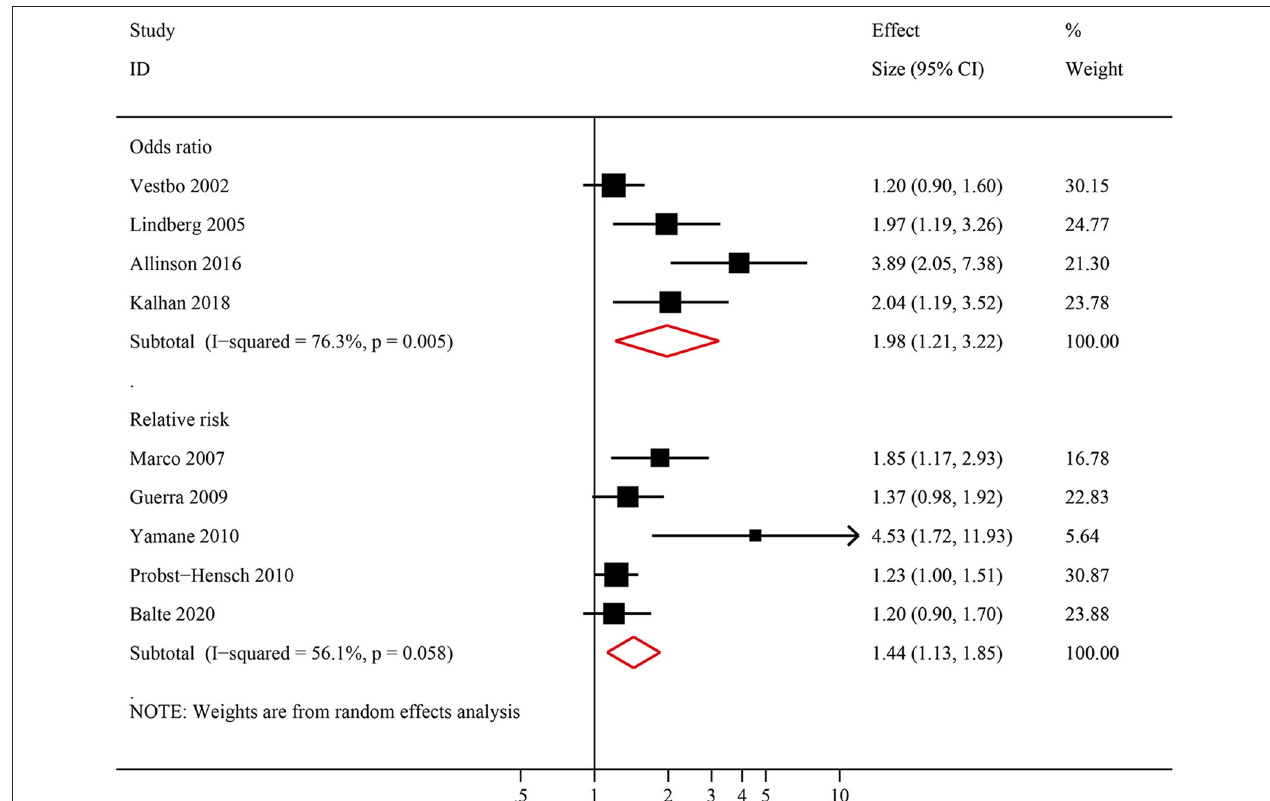
FIGURE 2 | Forest plot of the risk of incident chronic obstructive pulmonary disease in individuals with non-obstructive chronic bronchitis compared with individuals without non-obstructive chronic bronchitis. Without non-obstructive chronic bronchitis was defined as normal spirometry and no chronic